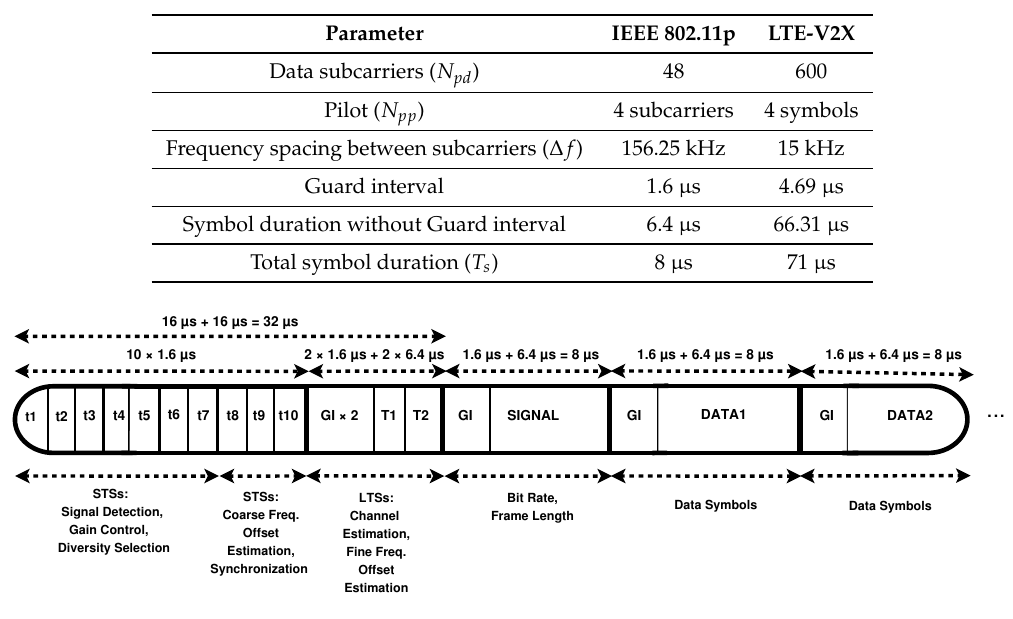
Table 1. OFDM symbol parameters for IEEE 802.11p and LTE-V2X with a 10 MHz bandwidth [11,14].